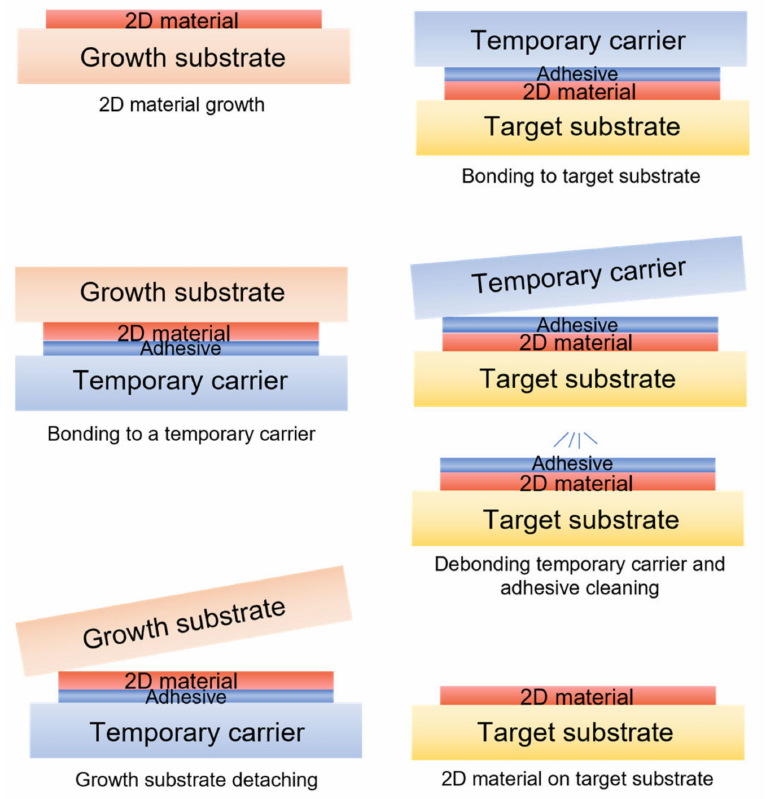
Figure 5. Two-dimensional layer transfer flow with TBDB